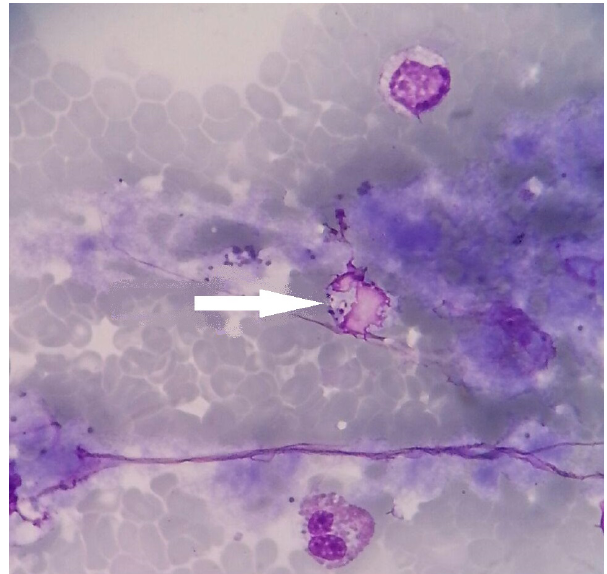
Figure 2. Bone marrow aspiration of case 2, showing Leishmania amastigots within macrophage.